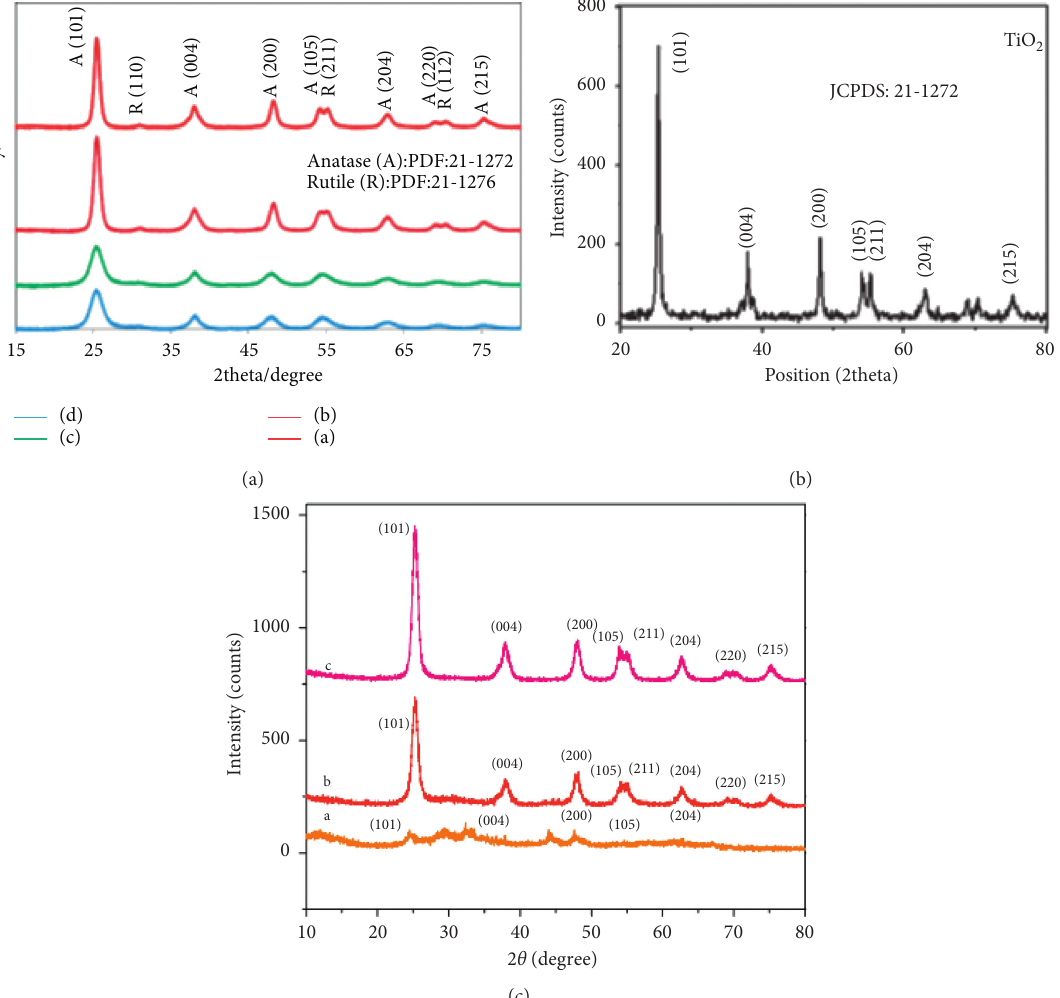
Figure 7: (a) Thyme (a), Alcea (b), and Alcea calcined at 500 ° C (c), and thyme calcined at 500 ° C (d), (b) Moringa oleifera -leaf-, and (c) root of Kniphofia foliosa- (a, 1: 2, b, 1:1, and c, 2:1) extract-mediated synthesized TiO 2 NPs [49, 67,